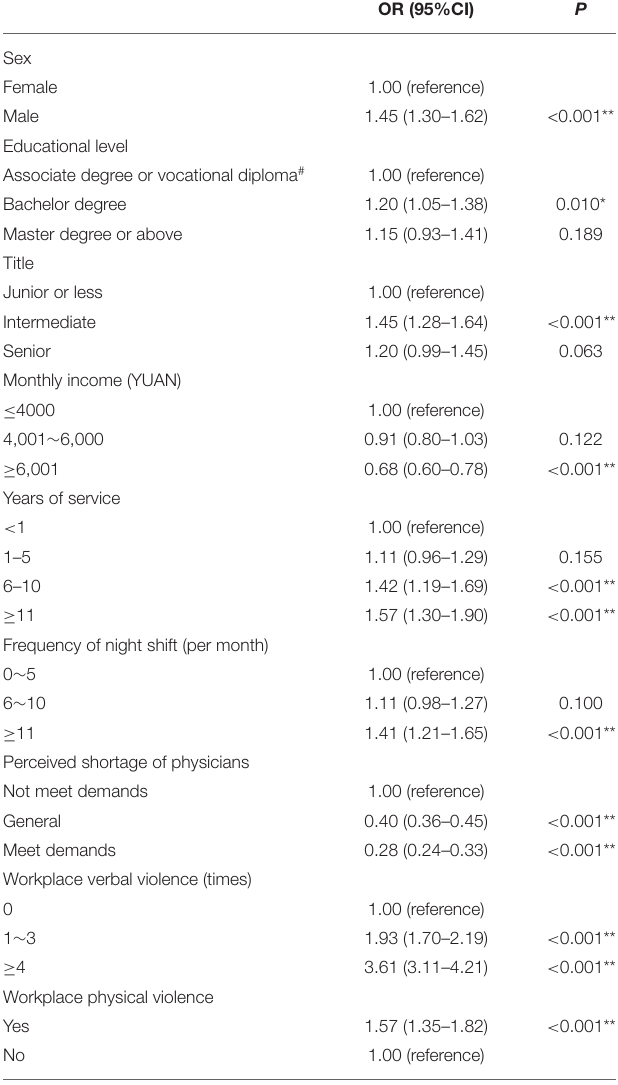
TABLE 2 | Binary logistic regression examining factors associated with